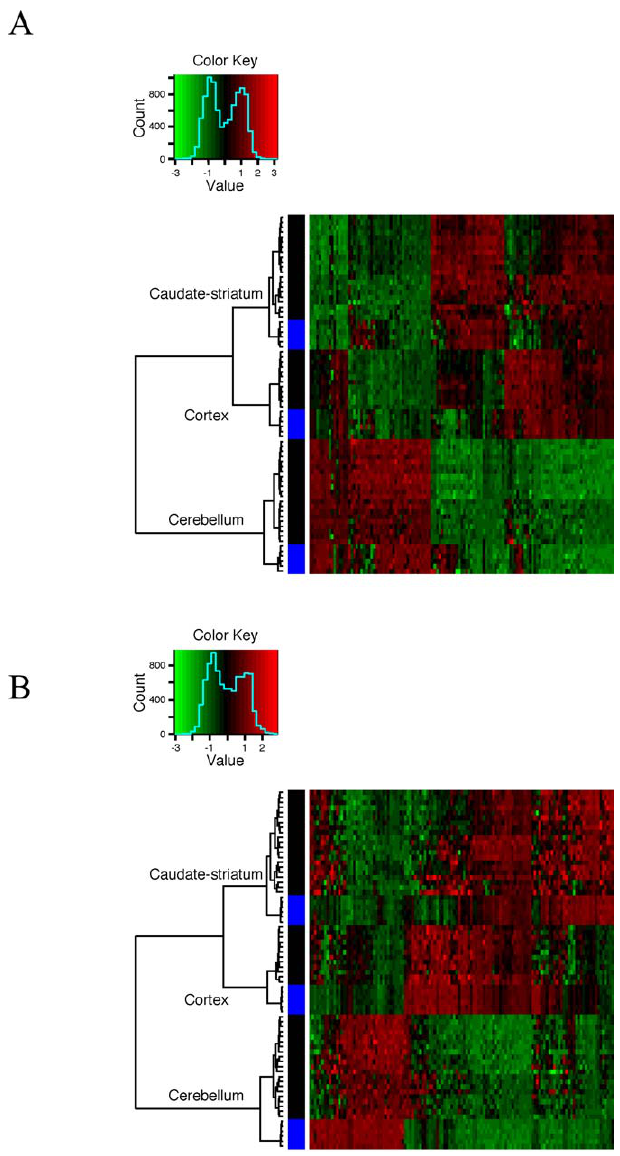
Figure 1. The Most Variable Genes in One Species Accurately Cluster the Brain Regions of the Other Species, and Orthologous Structures Cluster Together (A) Hierarchical clustering of regions and species using the 125 human genes in the one-to-one set with the highest variance across the 36 primary human arrays is shown. (B) Hierarchical clustering of regions and species using the 125 mouse genes in the one-to-one set with the highest variance across the 18 mouse arrays is shown. While variable genes were identified using only the primary human data, clustering included the secondary set of human data. The mouse, primary, and secondary human data were normalized separately. Expression levels are colored by standard deviation from the within-group mean. Columns represent genes. Rows represent samples with black bars on the left signifying human samples, and blue signifying mouse samples.